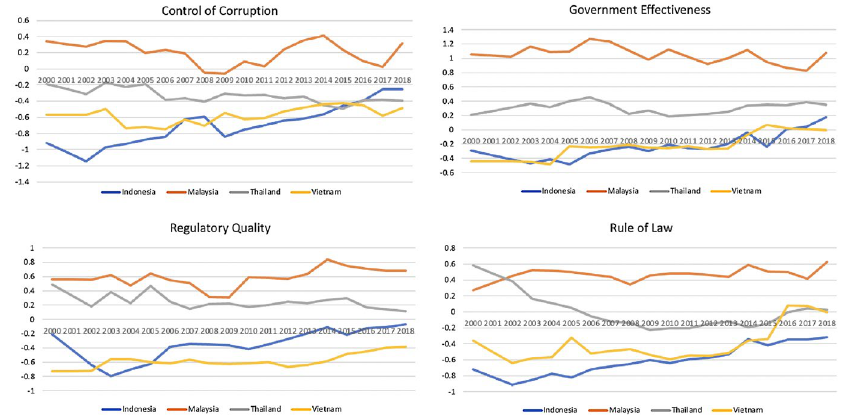
Fig. 3 Four dimensions of institutions quality related to international trade of main ASEAN exporter countries. Value of institution quality is an index ranging from strongest institutions. Source: Worldwide Governance